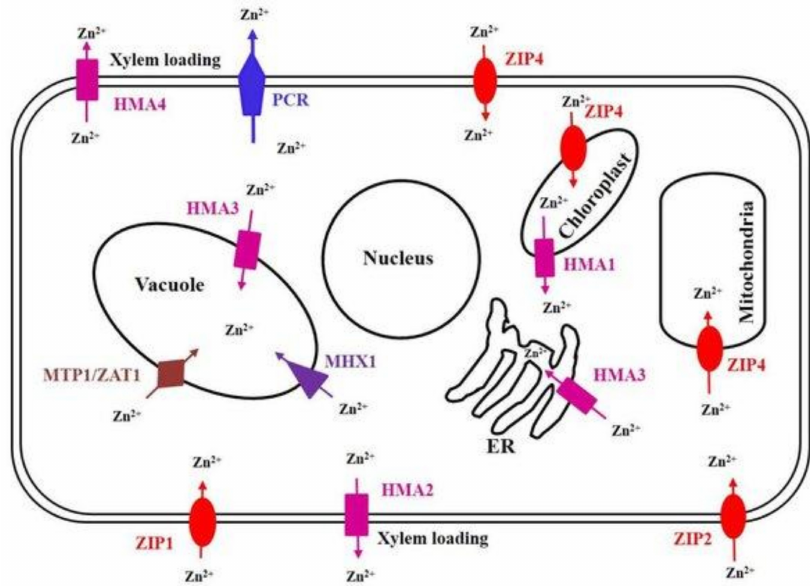
Figure 2. Localization of various Zn transporters in a plant cell. The Zn transporter family is actively involved in the uptake, transport, detoxification and homeostasis of Zn within plants. Depending on the Zn concentration in soil, various types of Zn transporters are expressed. During deficient concentration of Zn, ZIP (ZIP1, ZIP2 and ZIP4) and P-Type ATPase (HMA2), families of Zn transporters are induced which transport Zn into the cell through the plasma membrane from the soil, and then CAX (MHX1), CDF (MTP1 and ZAT1), P-Type ATPase (HMA2 and HMA4) and ZIP (ZIP4) families of transporters are